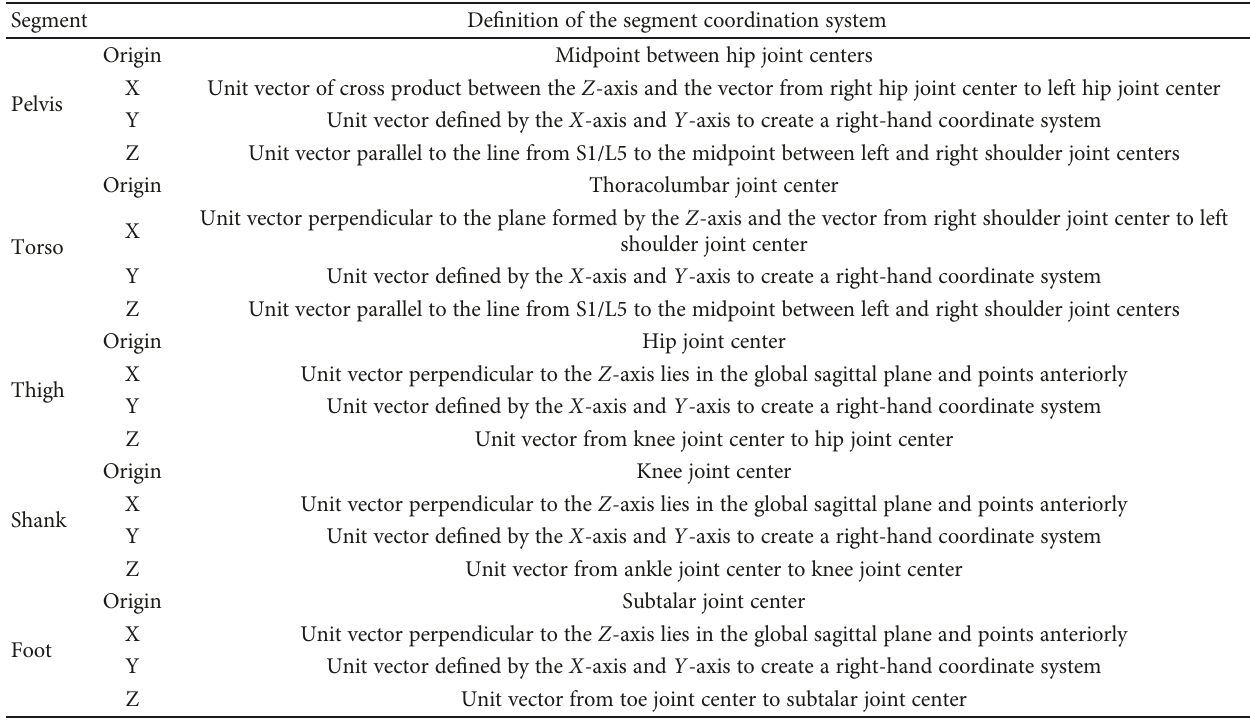
Table 2: Segment coordination